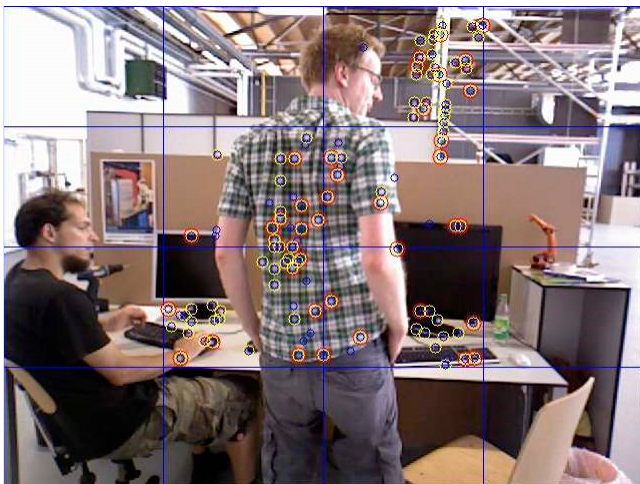
Figure 5. Solution result in grids containing mixed model. Red circles: eight features solving Grid model, blue circles: all matching feature points, and yellow circles: inliers of the Grid model.